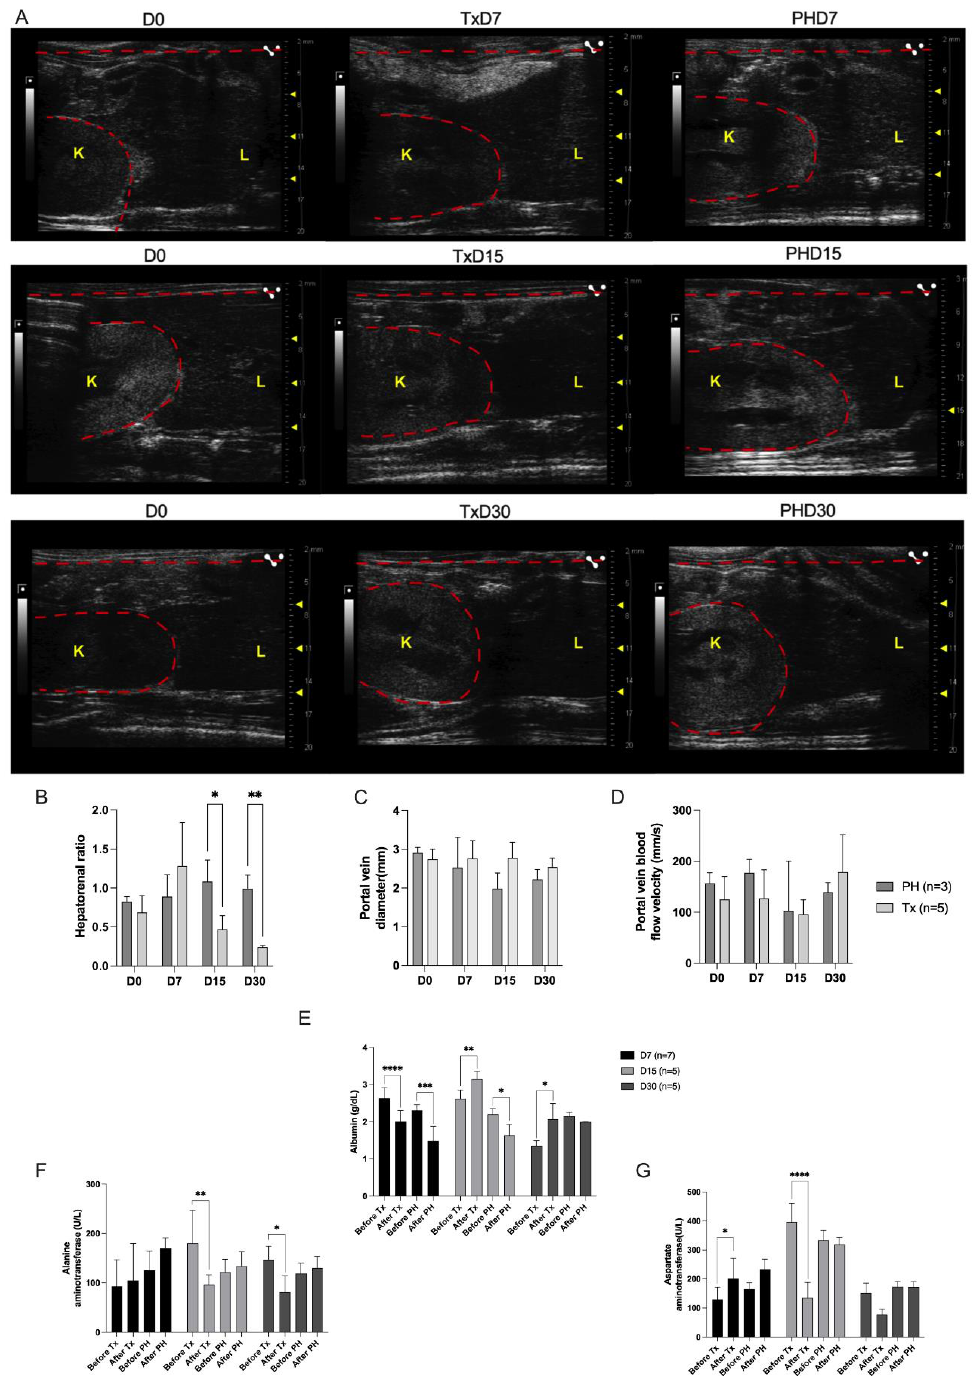
Figure 13. Acellular liver scaffold transplantation attenuates liver cirrhosis and contributes to the functional recovery of cirrhotic livers. Ultrasonographic images were derived from transplanted cirrhotic (Tx) and partial hepatectomy (PH) animals 7, 15, and 30 days post-transplantation ( A ). Measurements of the hepatorenal ratio ( B ), portal vein diameter ( C ), and portal vein blood flow velocity ( D ). L: Liver. K: Kidney (both are delimited by dashed red lines). Albumin ( E ), alanine ( F ), and aspartate aminotransferase ( G ) serum biochemical analyses in cirrhotic animals before and 7, 15, and 30 days post-transplantation (Tx) or partially hepatectomized (PH) animals. Significant differences were obtained after two-way ANOVA followed by Š í d á k’s multiple comparison test analysis (* p < 0.05, ** p < 0.005, *** p < 0.001, **** p <